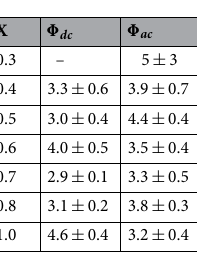
Table 1. Exponent describing the phase boundary in the T-H diagram separating paramagnetic and glassy behavior (Eq. 1). The exponent was obtained using both dc and ac susceptibility measurements (see subsection “Fixed H ac " )